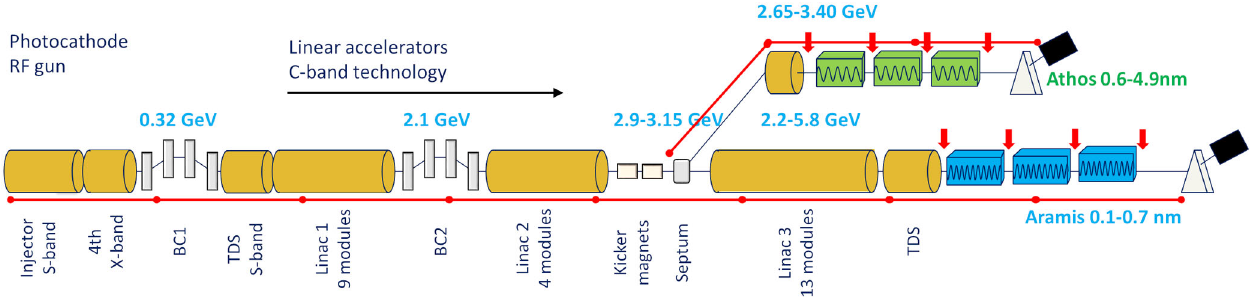
FIG. 2. Sketch of the SwissFEL accelerator with locations of loss monitors. The red lines show the quartz fibers of the LLMs covering the length of the machine, and the red arrows depict that there are BLMs and RadFETs located between undulators. Not all loss monitors and undulators are depicted in this